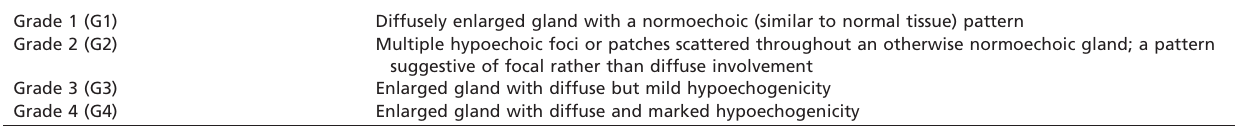
Table 1 - Grading system created by Sostre and Reyes (4).